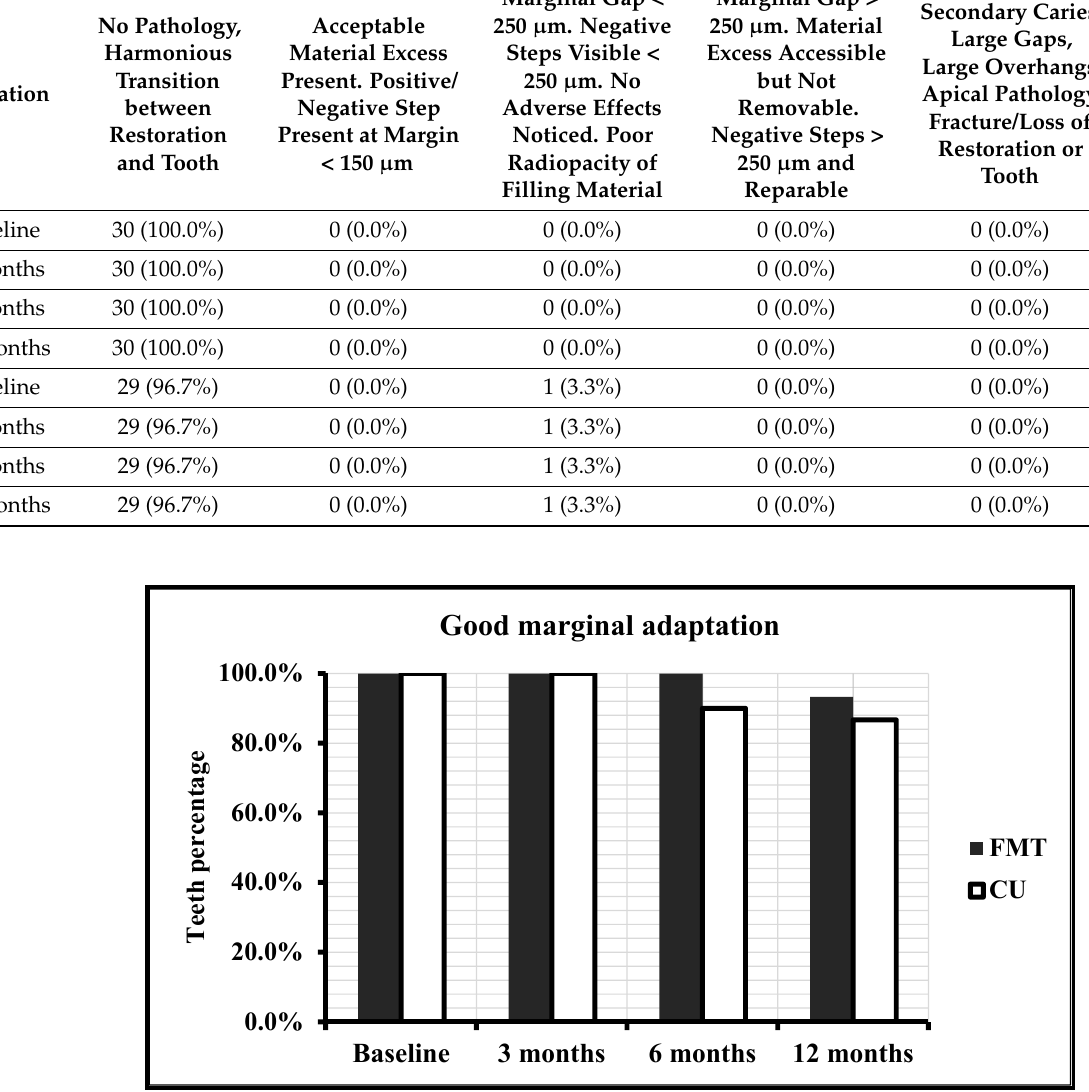
Table 8. Marginal staining of teeth restored with FMBT and CULT over time ( p < 0.05).